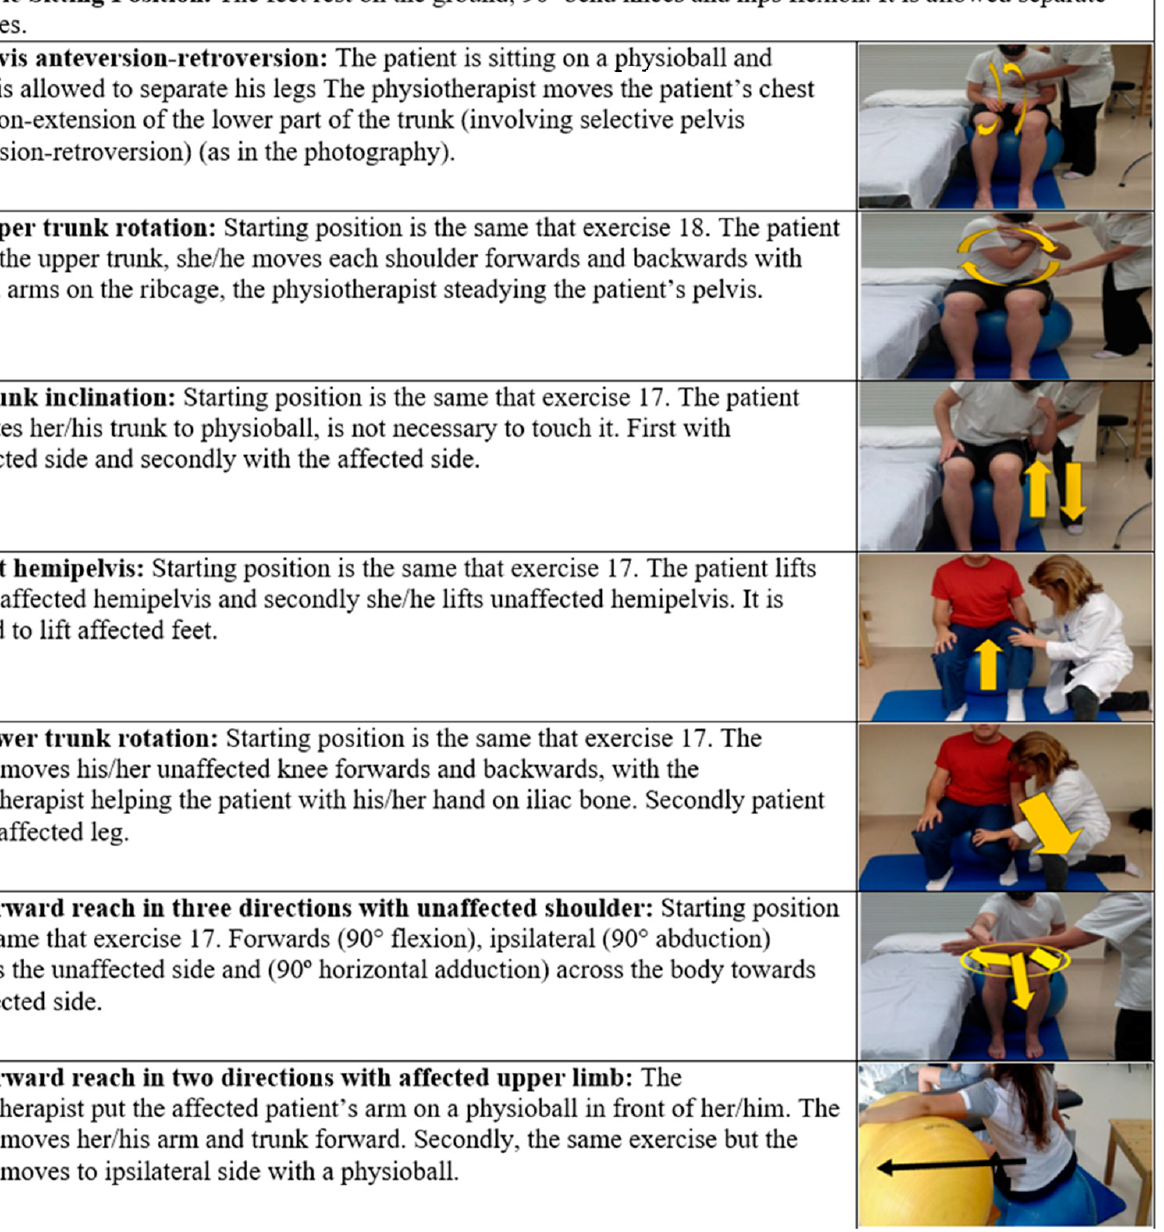
Figure 1. Core stability exercises